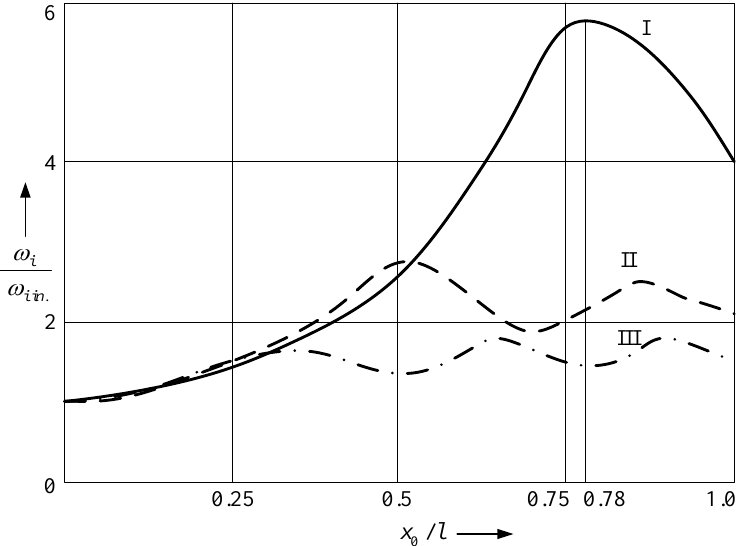
Figure 8. Dependences of the ratio between the circular natural frequencies of the supported microstructure ω and those of the unsupported one ω i support ( i = I, II,